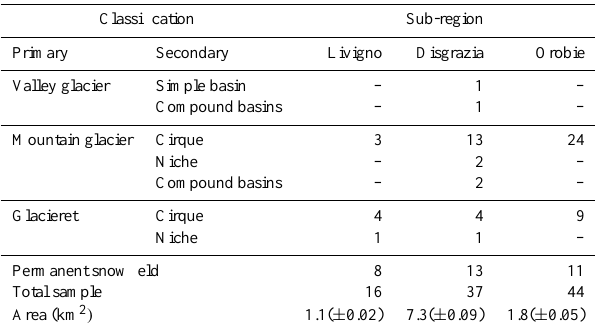
Table 2. Glacier characteristics in the study sub-regions as invento- ried in